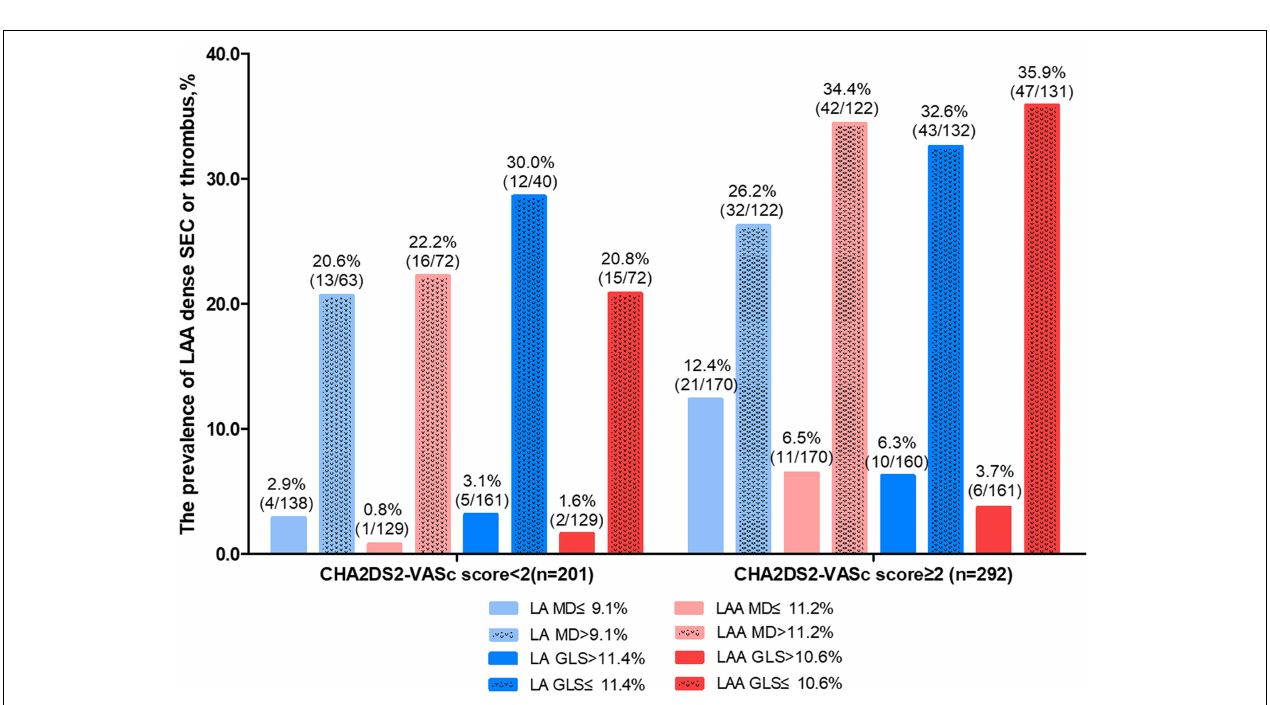
FIGURE 3 | Incremental values of LAA and LA mechanics for risk stratification of LAA dense spontaneous echo contrast or thrombus. The initial model was based on CHA2DS2-VASc score, LVEF, LAVI max and LAA FV. LA MD, LAGLS, LAA GLS, and LAA MD was sequentially added to the initial model in different order and the global χ 2 value was compared. The parameter added in the last step was LAA MD (A) , LAA GLS (B) , LA MD (C) , and LA GLS (D) . The addition of LA MD provided no incremental value over other LA/LAA mechanical parameters. GLS, global longitudinal strain; LA, left atrium; LAA, left atrial appendage; LAAFV, LAA filling velocity; LAVI, LA volume index; LVEF, left ventricular ejection fraction; MD, mechanical dispersion.